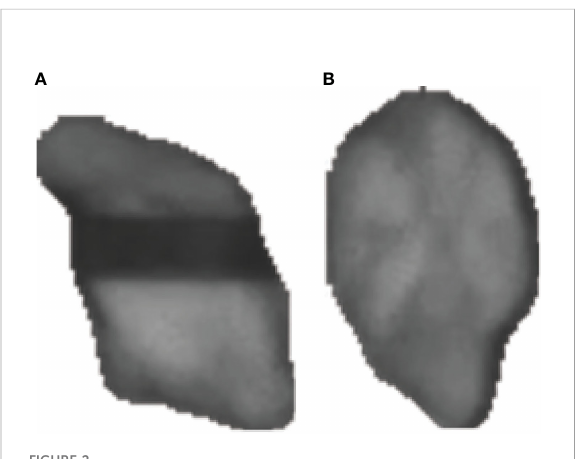
FIGURE 2 Example of (A) not perching broiler and (B) perching